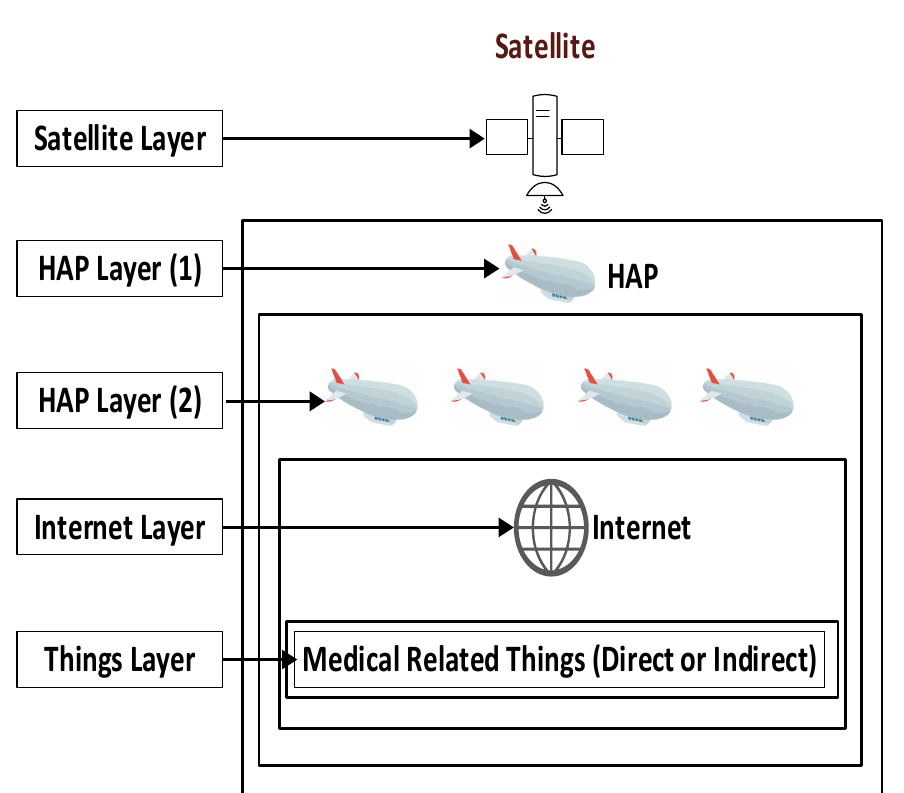
Figure 6. Simple view of the proposed simulated architecture. The second objective of the simulation is to make the networks forming the IoT enjoinment connect devices with a direct relationship to the medical field and devices serving the medical system in general. In this simulation, the devices to be included have been studied so that the simulation system can include any device with a medical relationship under the umbrella of an IoT-enabled healthcare system. Initially, devices were divided into “active” and “passive”. As stated above, active devices can connect to any coverage tool, such as the Internet, and have a processing unit (optional), and passive devices cannot contact any coverage tool. For this, active devices are communicated using a WSN, MANET, or cellular network, and passive devices are communicated to the IoT- enabled healthcare system using RFID networks supported with other tools, such as RFID tags (see Figure 7). Table 3 lists the values of the medical variables required to represent the healthcare system in the IoT